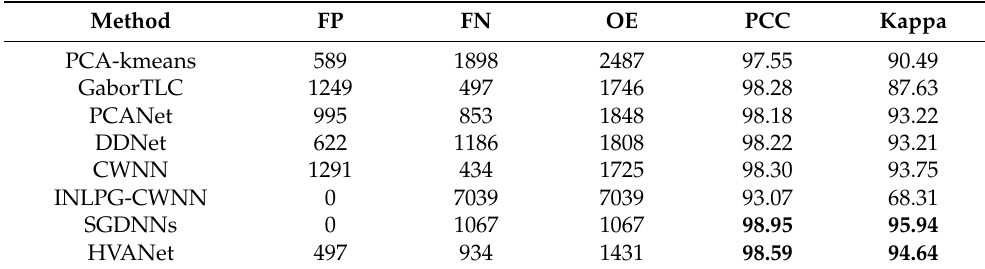
Table 8. Change detection results of each method on Ottawa